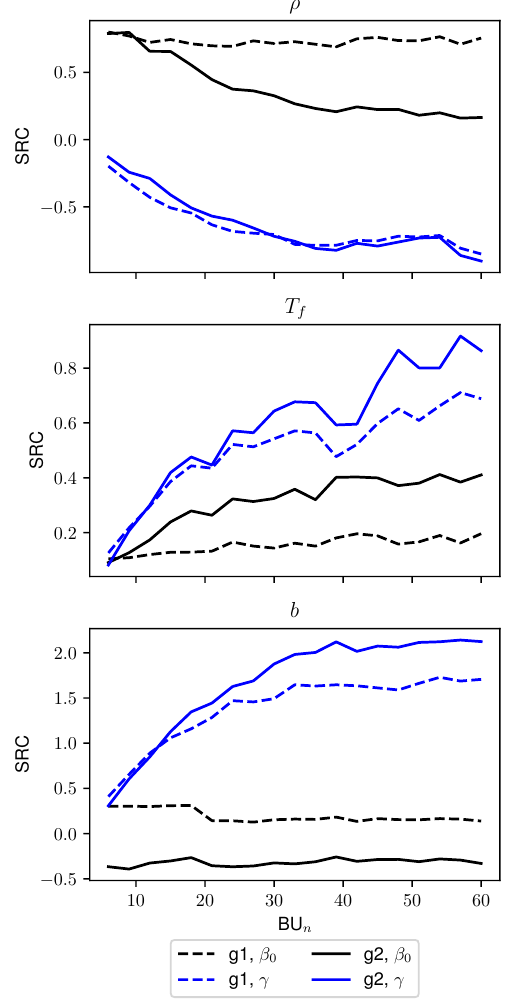
Figure 8. Sensitivity measures for both groups of Σ f from the SRC method for both burnup-averaged state variables ( γ ) and state variables at the burnup where the HXS is calculated ( β 0 ) as a function of burnup. Sensitivity measures calculated at each burnup step using the RHM where Q = 0. In the legend, g# indicates the energy group of the HXS for which the sensitivity measure